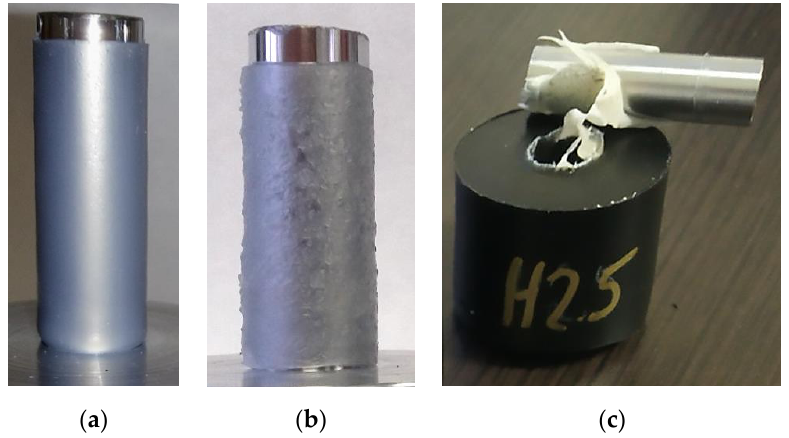
Figure 11. ( a ) Sintered powder—120 s treatment time; ( b ) sintered powder—1200 s treatment time; ( c ) adhesion failure between P-PE and black plastic collar.